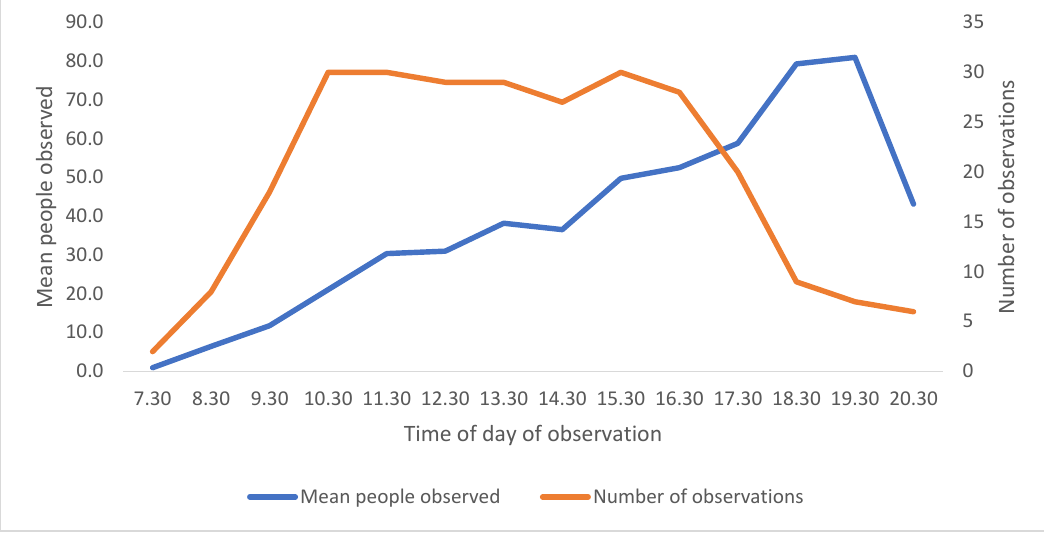
Figure 1. Time of day by average number of people observed by number of observations. Note this figure depicts the time points where data were consistently collected across all observation sites, being on the half hour. Table 3. Di ff erences in river exposure by sex by in, on, or beside the river; time of day; and day of week. People Per